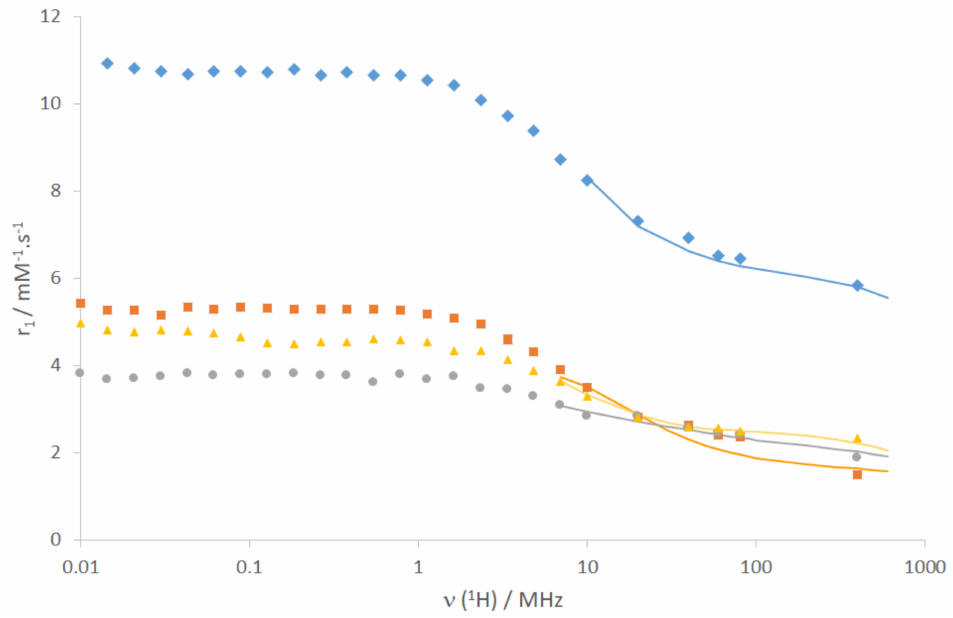
Figure 1. 1 H Nuclear Magnetic Relaxation Dispersion (NMRD) profiles of GdL1 (  ), GdL2 (  ), GdL3 (  ) and GdL4 (  ) at 37 °C. The lines represent the best fit to the SBM equations.